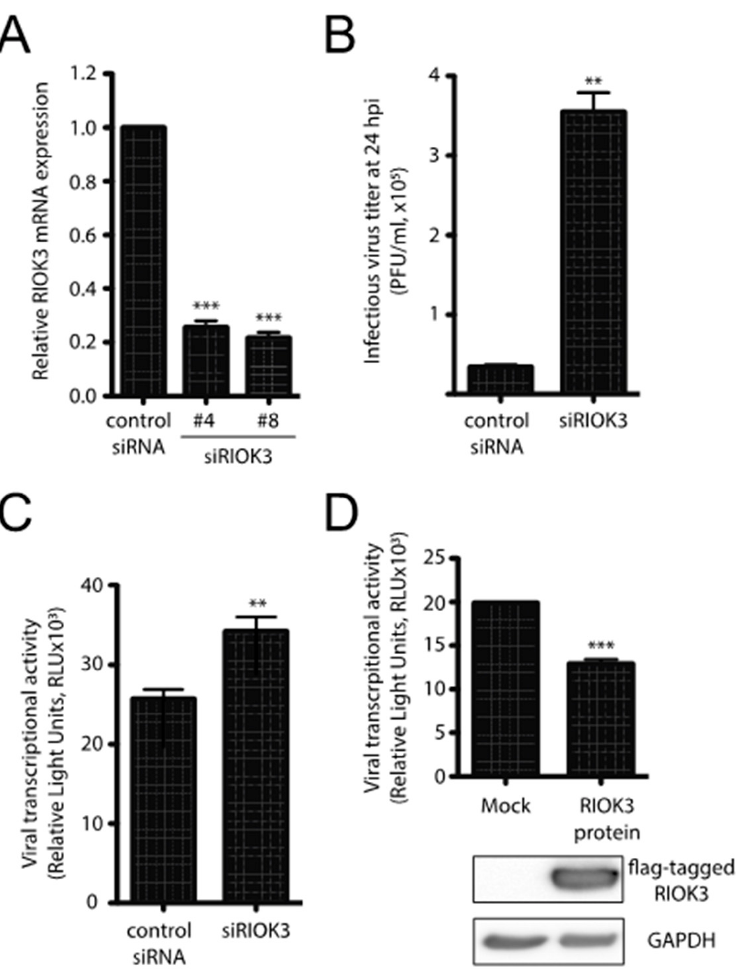
Figure 1. RIOK3 plays an antiviral role during RVFV MP-12 infection. ( A ) siRNA knockdown of RIOK3. HEK293 cells were transfected with RIOK3 (Qiagen nos. Hs_RIOK3_4 and Hs_RIOK3_8) or control siRNAs. Total RNA was extracted and RIOK3 mRNA was quantified by RT-qPCR. ( B ) Effect of RIOK3 knockdown on MP-12 titer. HEK293 cells were transfected with mock or RIOK3 siRNAs, then infected with RVFV strain MP-12. The viral titer in the supernatant at 24 hpi was quantified by plaque assay. ( C ) Effect of RIOK3 knockdown on rLuc RVFV transcriptional activity. HEK293 cells were transfected with siRNA targeted to RIOK3 or a negative control and infected with rLuc RVFV. The Renilla luciferase activity was quantified at 24 hpi and indicated the level of RVFV transcriptional activity. ( D ) Effect of RIOK3 overexpression on rLuc RVFV transcriptional activity. Cell lysates were prepared from HEK293 cells transfected with N-terminally FLAG tagged RIOK3 or mock transfected and protein levels were determined by Western blotting. Transfected cells were infected with rLuc RVFV and the level of Renilla luciferase activity was quantified at 24 hpi. In all panels, data are presented as mean +/ − SEM of duplicate ( C ) or triplicate ( A , B , D ) biological replicates. Student’s t -test: *** p < 0.001, ** p <